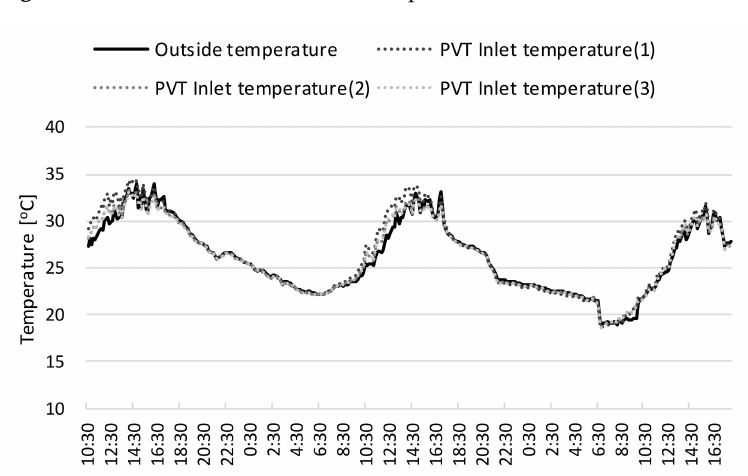
Figure 4. Inlet temperatures of the photovoltaic/thermal (PVT)